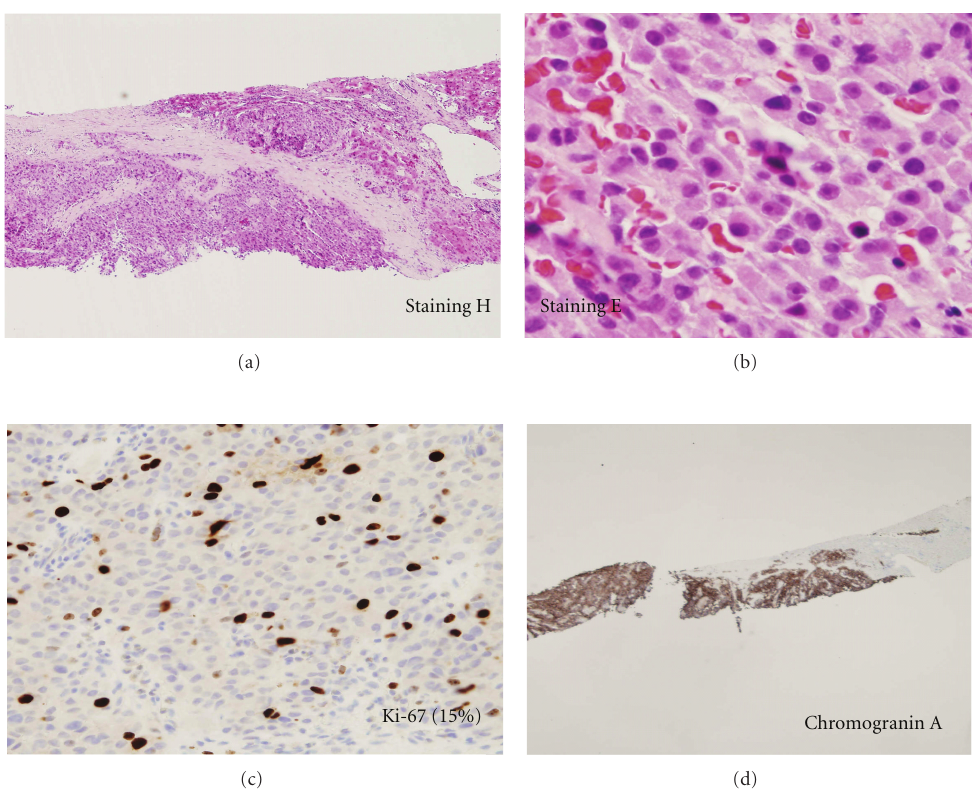
Figure 2: US-guided liver biopsy staining H & E (a) demonstrating a rather uniform population of sheets of small cells arranged in manner ( × 40 in (b)). Immunohistochemistry with a Ki-67 marker (Mib-1) (c) estimated here to be 15% and positive immunostaining with chromogranin A